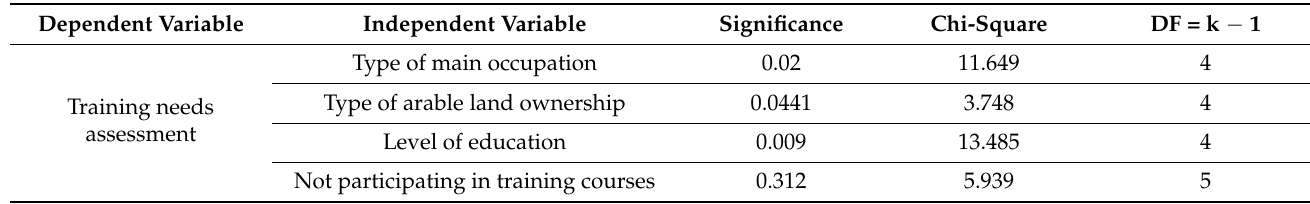
Table 3. Results of the Kruskal–Wallis